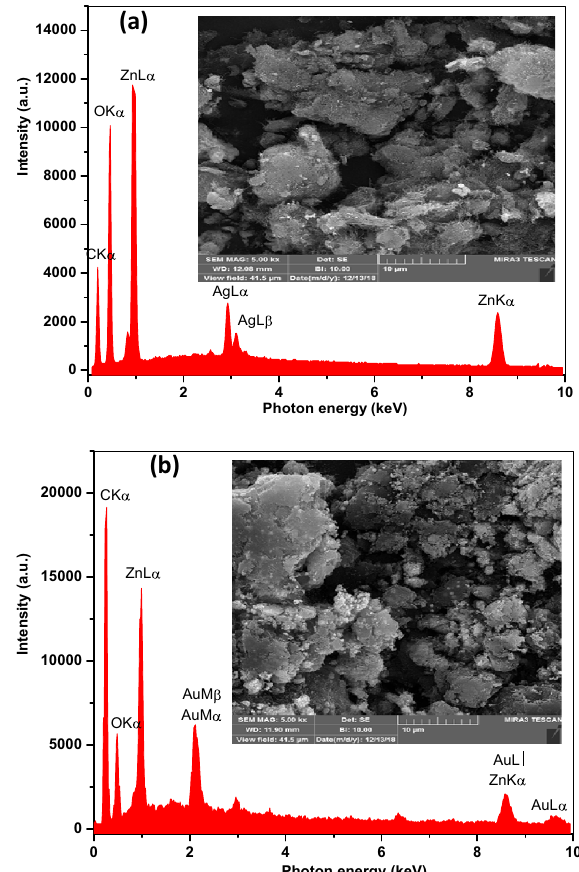
Figure 3. SEM and EDS analyses of, ( a ) ZnO–Ag-SWCNTs, and ( b ) ZnO–Au-SWCNTs.